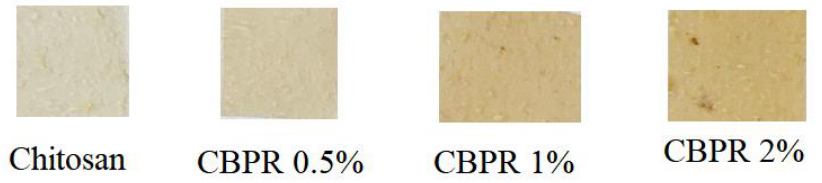
Figure 1. Photographs of the prepared films.